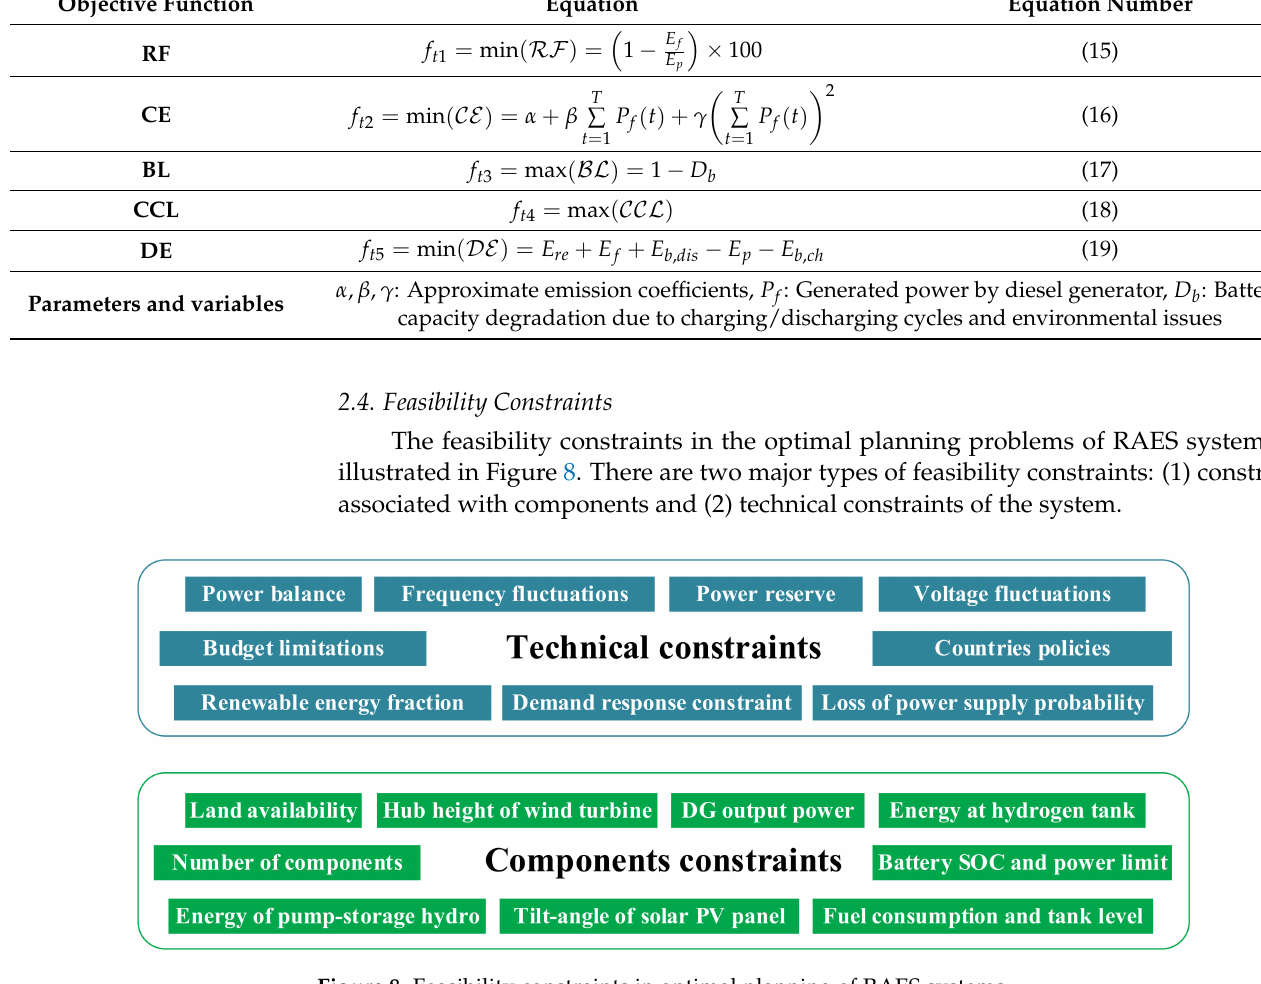
Figure 8. Feasibility constraints in optimal planning of RAES